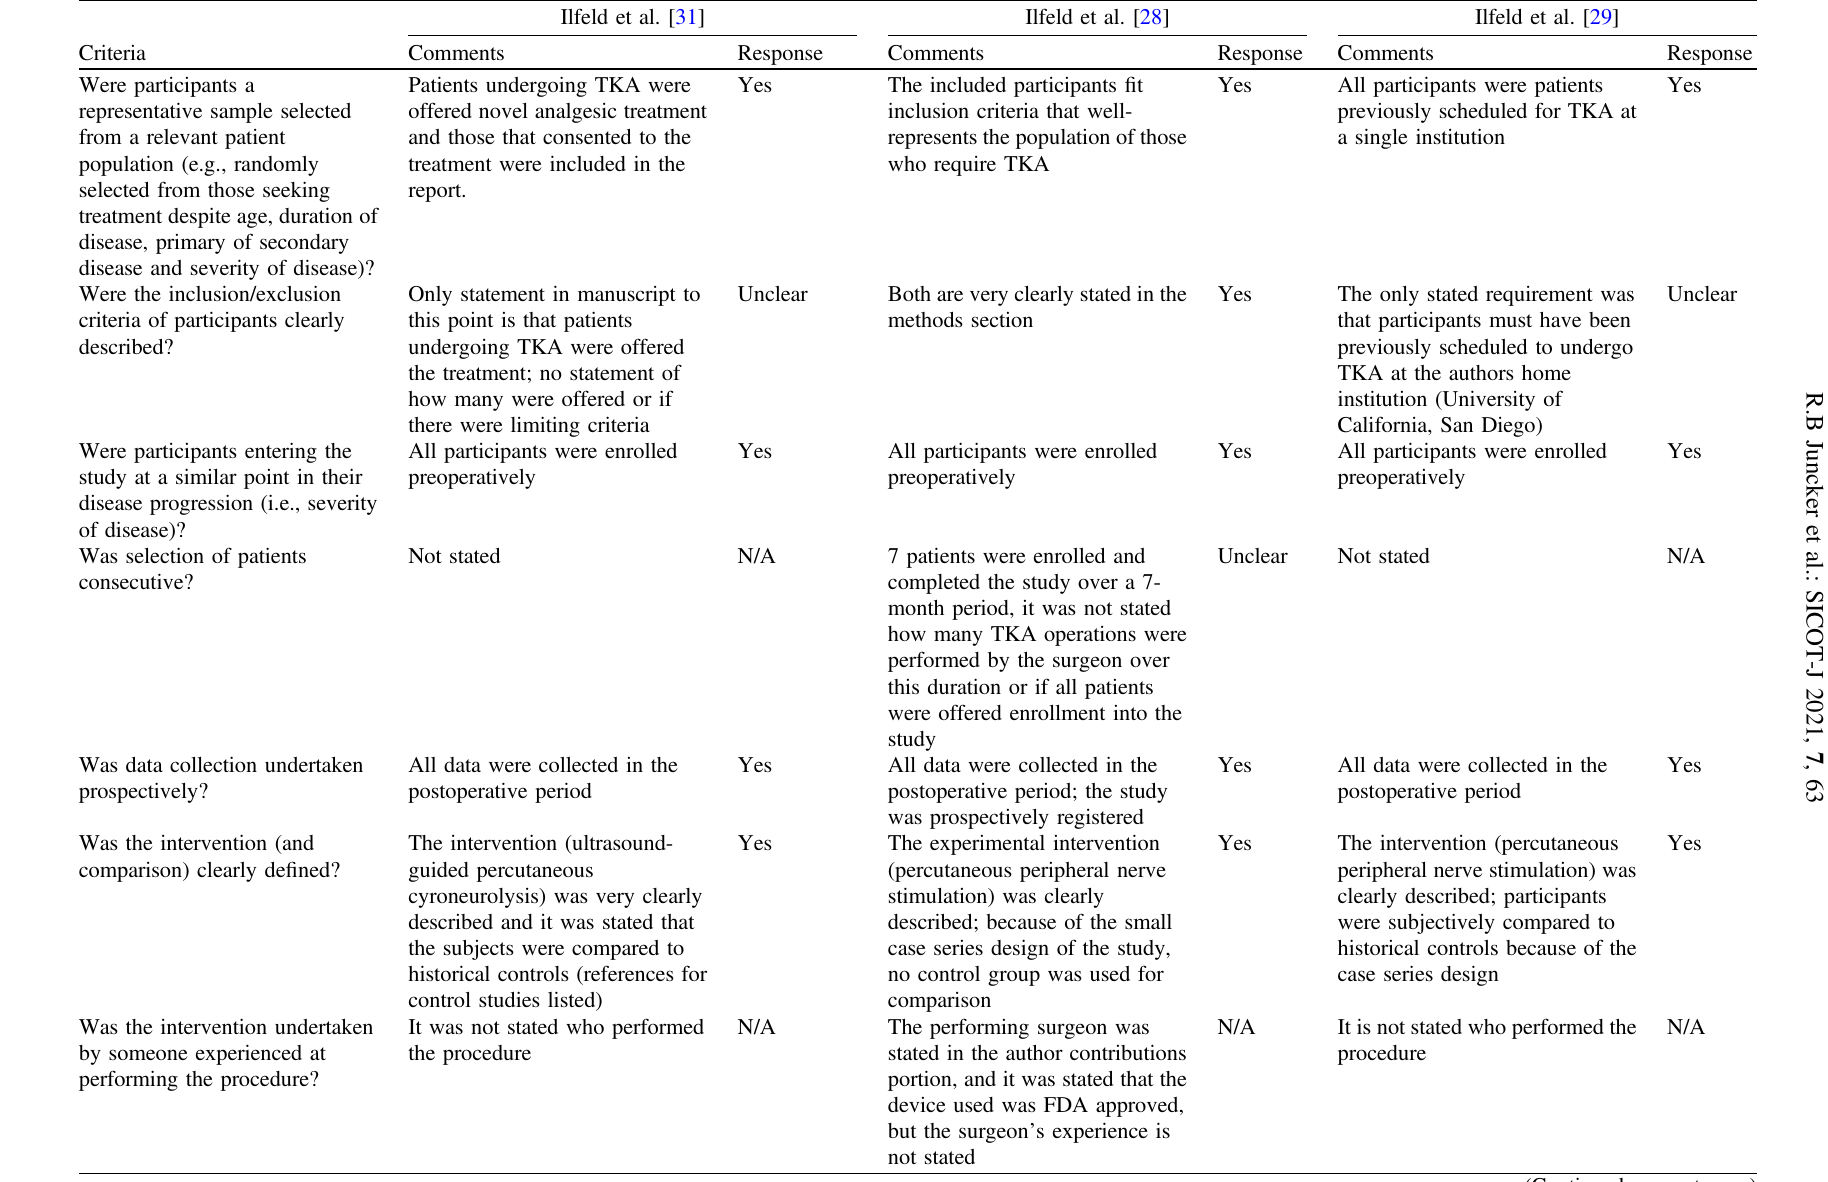
Table 3. ROB/quality assessment for case